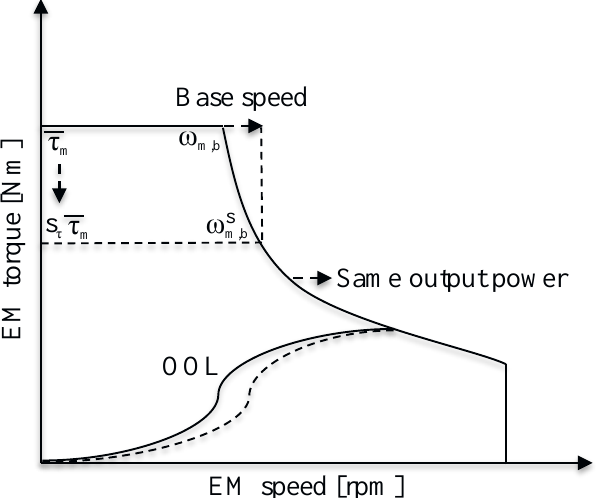
Figure 8. Scaling factor of the EM including the DC-AC inverter, where the solid lines represent the original EM, dashed lines the scaled EM while keeping the same output power, and optimal operating line (OOL) the optimal operating line minimizing the EM losses for every power